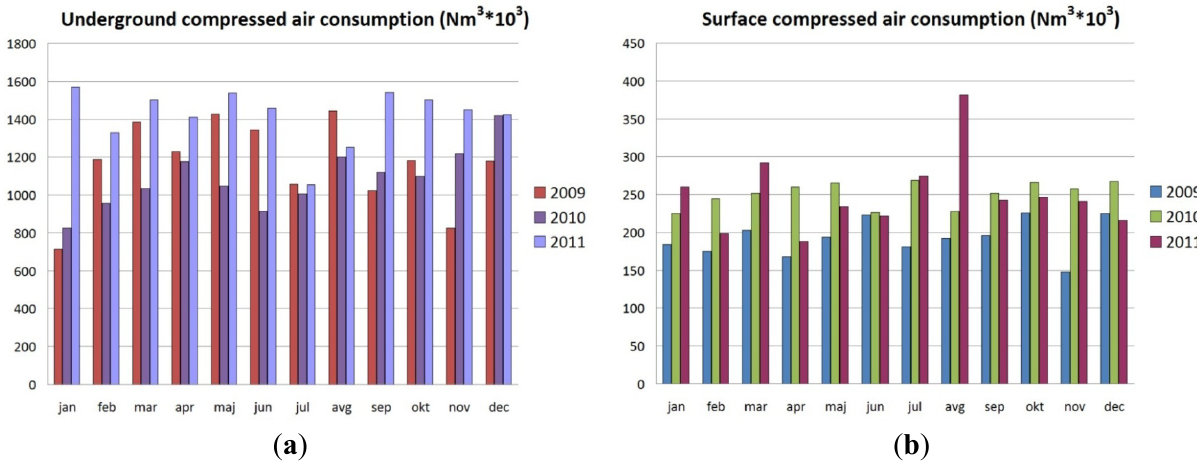
Figure 12. Compressed air consumption in years 2009 to 2011: ( a ) in underground mining processes; ( b ) on surface